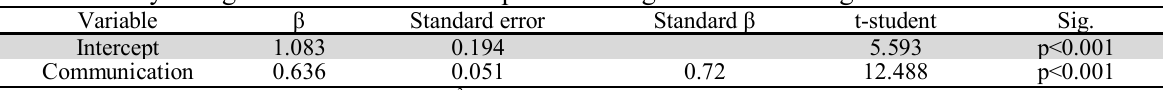
The summary of regression model between perceived organizational change and communication Variable β Standard